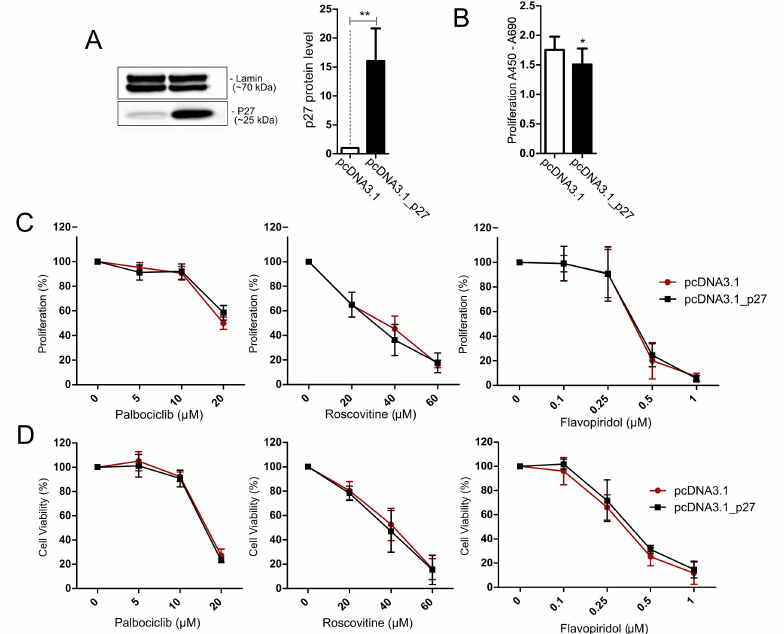
Figure 6. Treatment of AtT-20/D16v-F2 cells overexpressing p27 with cell cycle inhibitors. ( A ). Expression of p27 in AtT-20/D16v-F2 cells after transfection with expression plasmid vec- tor with Cdkn1b coding sequence (pcDNA3.1_p27) and control cells (transfected with empty vector pcDNA3.1) as determined with Western blot and quantified with densitometry; ** indicates p < 0.001; ( B ). Proliferation rate in AtT-20/D16v-F2 cells with p27 overexpression and control cells; * indicates p < 0.05; ( C ). The effect of the cell cycle inhibitors palbociclib, roscovitine and flavopiridol on prolifer- ation rate of cells overexpressing p27 and control cells as measured with the BrdU assay. ( D ). The effect of cell cycle inhibitors on viability of cells with p27 overexpression and control cells, measured with the MTT